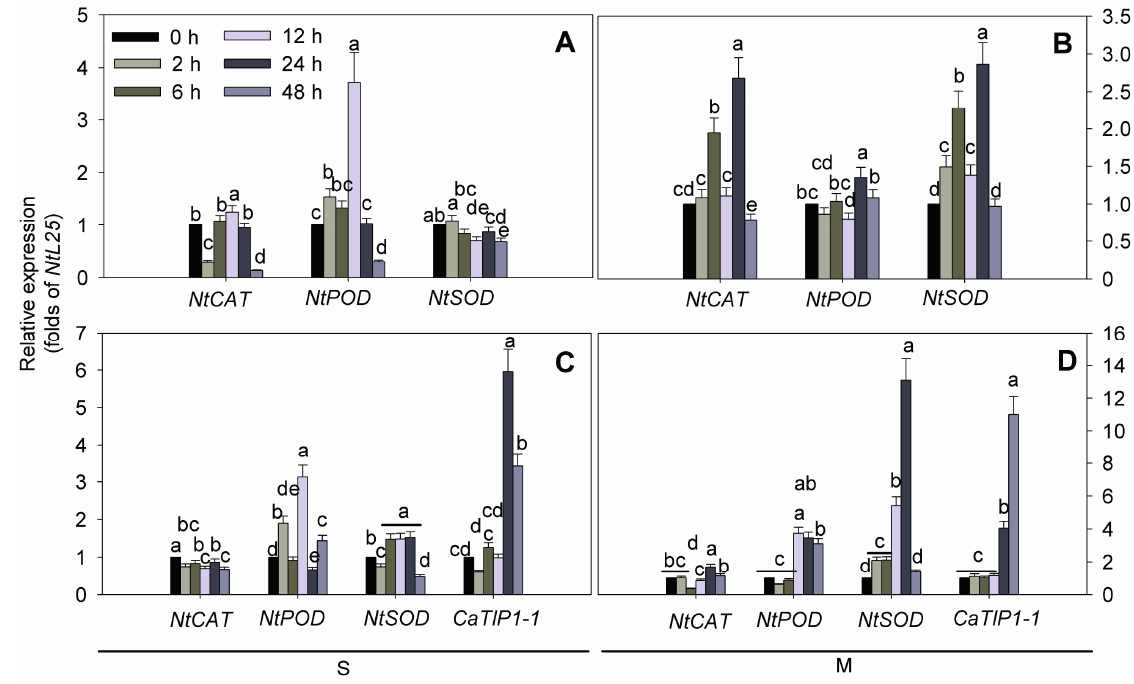
Figure 7. Quantitative RT-PCR was used to assess the transcript levels of CaTIP1-1 , NtCAT , NtSOD and NtPOD in the leaves of the transgenic lines and the wild-type. The relative fold differences in the mRNA levels were calculated using the 2 −∆∆ C t formula with NtL25 as the internal control. Bars with different lower case letters in each group were significantly different, as determined using Duncan’s multiple range test ( p <